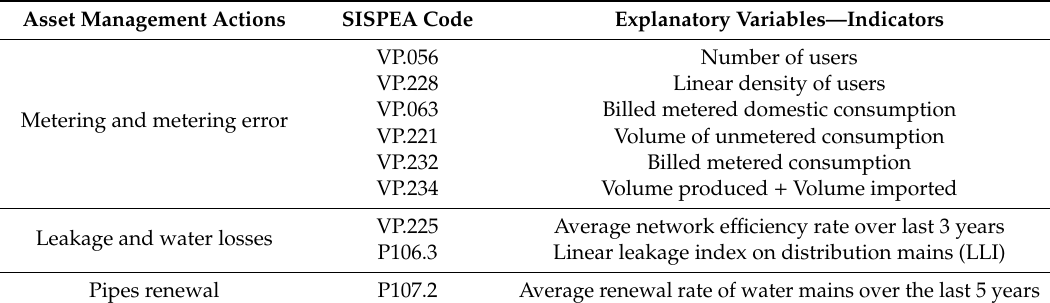
Table 1. Explanatory variables for e ffi ciency